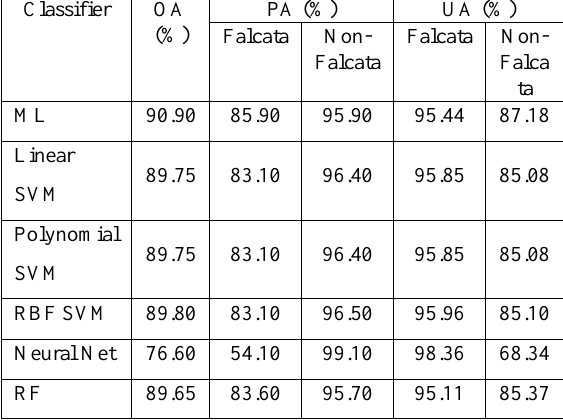
Table 2. Summary of accuracies for the 10-m resolution Sentinel-2 image classifications. (OA = Overall Accuracy; PA =